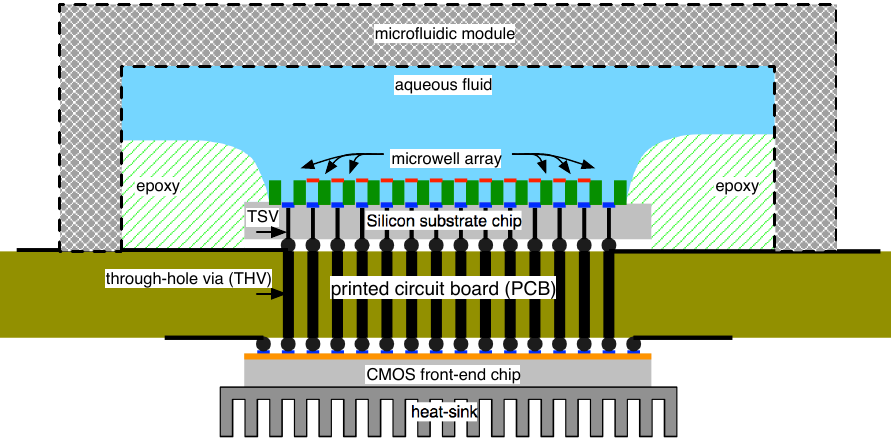
Figure 18. Cross-section of an example construct for connecting the nanopore sensor system to external system components. The construction of sensing structures and electronic structures on separate silicon substrates offers substantial room for the optimization of each